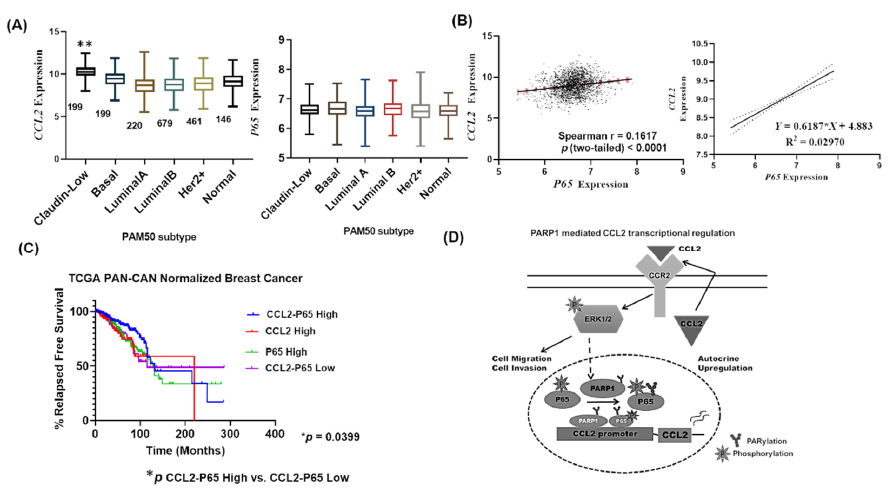
Figure 6. CCL2 and P65 mRNA expression are positively correlated in breast cancer and affect relapsed free survival ( A ) METABRIC Dataset showing CCL2 (Left) and P65 (Right) mRNA expression as determined by microarray analysis. Breast cancer patients are classified based on the PAM50-Claudin Low signature on the horizontal axis. The numbers in the figure represent the total number of patients in each group. CCL2 expression is significantly higher in the Claudin-low type (One way ANOVA followed by Tukey’s multiple comparisons. ** p < 0.001 vs. Normal). ( B ) Left: Correlation of CCL2 and P65 mRNA expression in patients. Spearman correlation with a two-tailed test for p . Right: Linear regression showing an association between P65 and CCL2 mRNA expression. Dotted lines were showing confidence bands representing the confidence interval of the best fit line (solid). ( C ) Kaplan-Meier survival curve showing relapsed free survival (RFS) in patients categorized based on high and low (median split) CCL2 and P65 expression. TCGA breast cancer patients from KMPLOT. Log-Rank Wilcoxon p for CCL2-P65 High vs. Low groups. ( D ) Model of PARP1 and CCL2 pathways interaction upregulating invasiveness in breast cancer. CCR2 is shown as the cognate receptor for CCL2. CCL2 binds to CCR2 and activates MAP Kinases, which results in the downstream activation of PARP1 and P65, followed by their recruitment to the CCL2